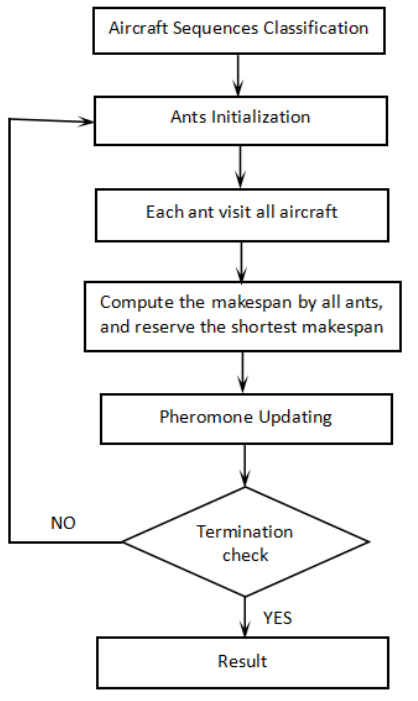
Figure 4. The complete RMA-AC